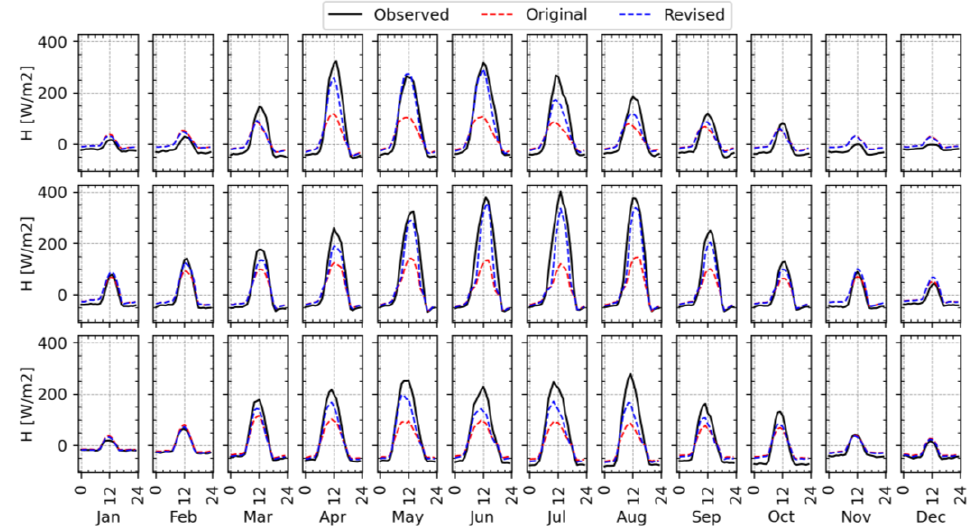
Figure 10. Time-averaged diurnal variations in the observed and simulated sensible heat flux by the original and the revised parameterization at Evergreen Needle-leaf Forest (EBF) sites. The top row corresponds to the Loobos site in the Netherlands (NL-Loo), the middle row to the Le Bray site in France (FR-LBr), and the bottom row to the Oberbärenburg site in Germany (DE-Obe). Statistically, it is observed in Figure 11 that the revised parameterization outperforms the original parameterization at all the ENF sites based on all three evaluation metrics. Significantly higher R 2 values and lower RMSE and bias values are observed across the three ENF sites.